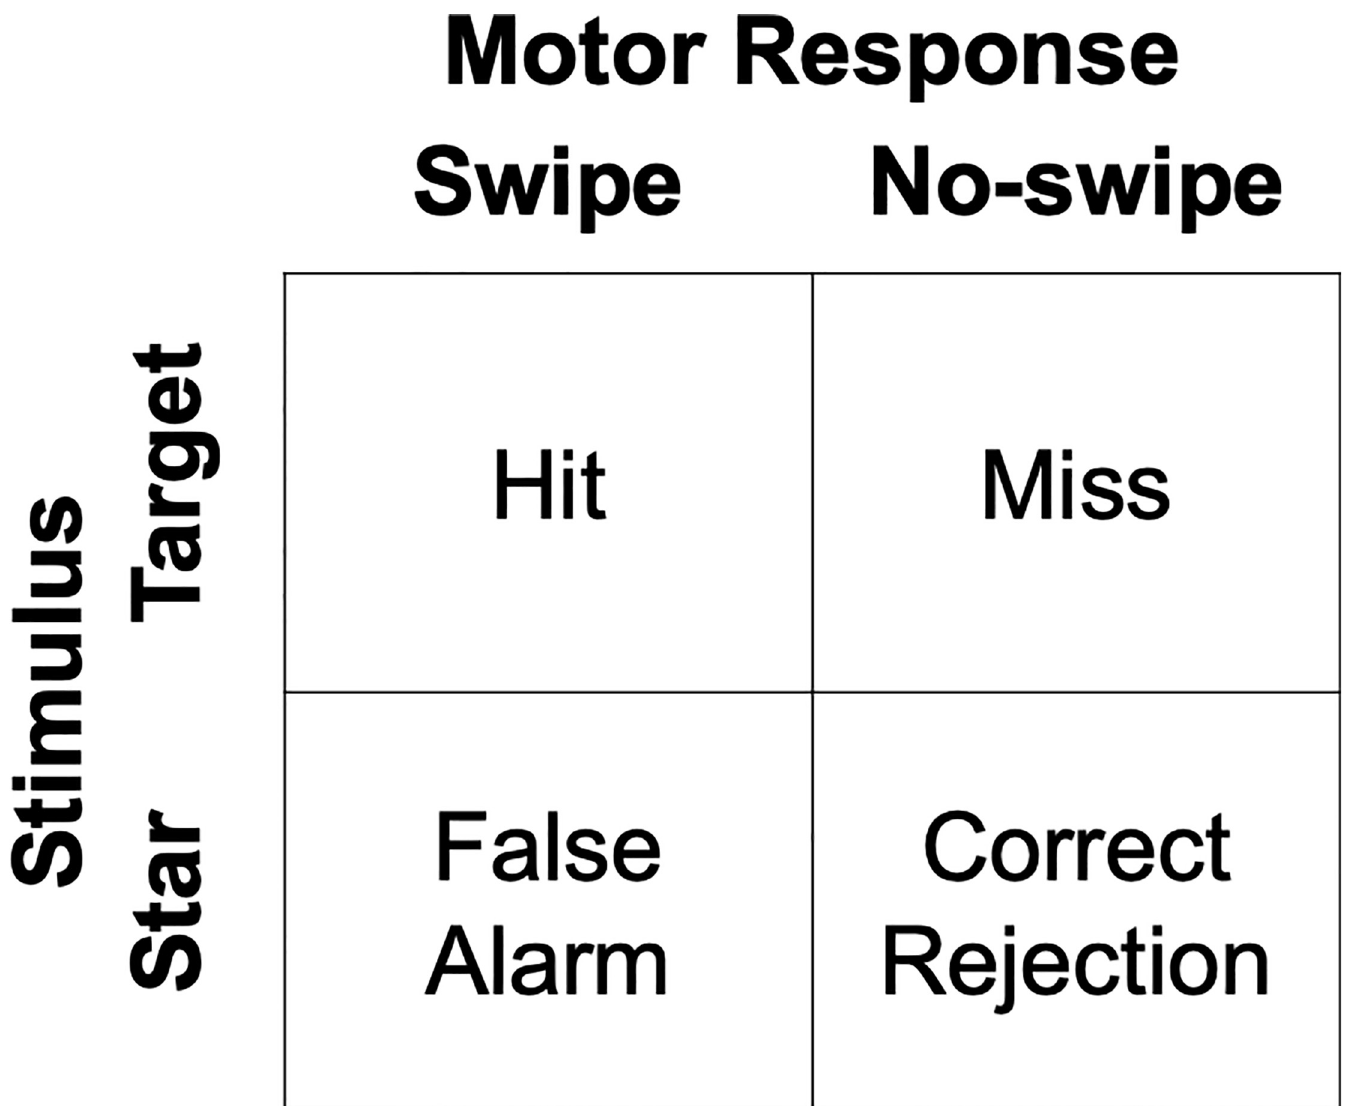
Fig 2. Signal detection theory operationalization of mobile application-based